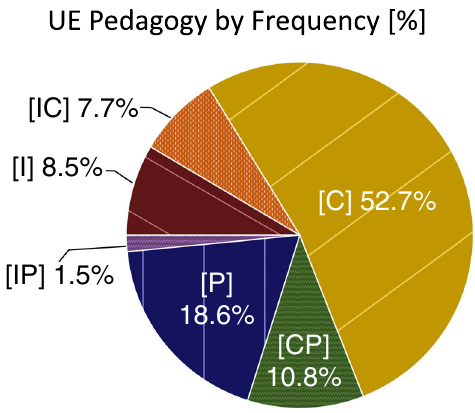
FIG. 3. Percentage prevalence of each pedagogical mode we observed. Similar to Ref. [12], we observed a majority of pedagogy to involve consultationlike techniques, but did observe occasions of the other